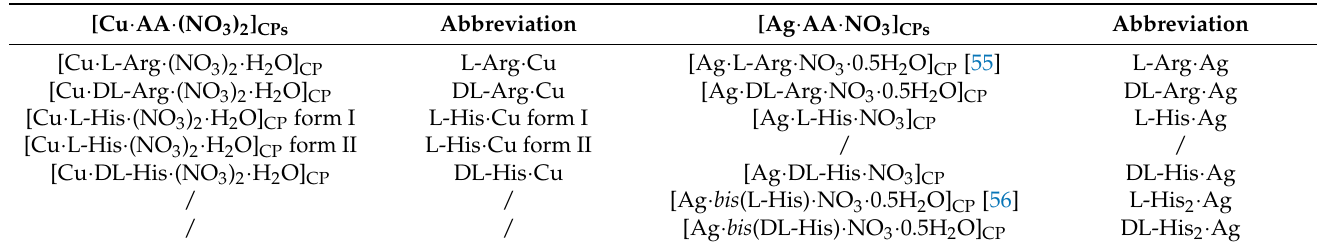
Table 1. List of the coordination polymers prepared and discussed in this work, with the respective adopted